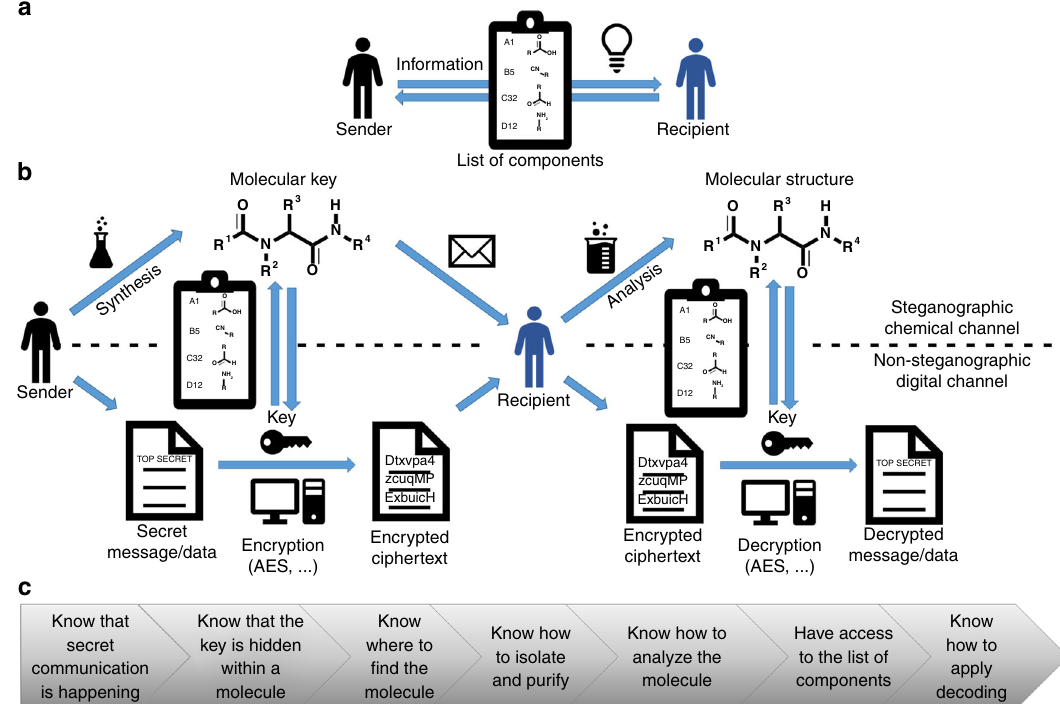
Fig. 2 Steganographic key distribution. a The sender and recipient discuss details about their secret communication and exchange the list of components (assigns chemical information to alphanumerical symbols). b from left to right: The sender synthesizes one or several molecular keys and determines the alphanumeric code associated with the chemical structures according to the list of components. The alphanumeric code, e.g., A(001)-B(012)-C(007)-D(007) is serving as encryption key. The molecular key is concealed and transferred to the recipient via a steganographic channel. The recipient isolates the key and elucidates the molecular structure for decryption. c Levels of security and knowledge an adversary needs for decrypting the